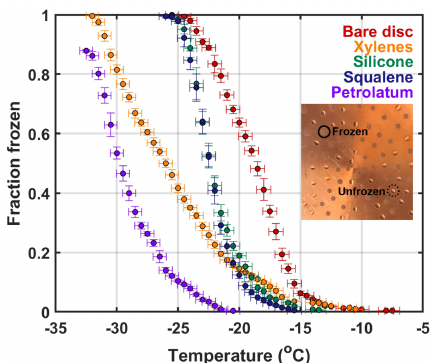
Figure 3. Histogram of temperature differences between measure- ments from a probe at the center of the copper plate and drop on top of the plate coated with petrolatum colored by cooling rate. The 1s data are from three different tests. The average difference used for the temperature correction was 0.33 ± 0.15 ◦ C.